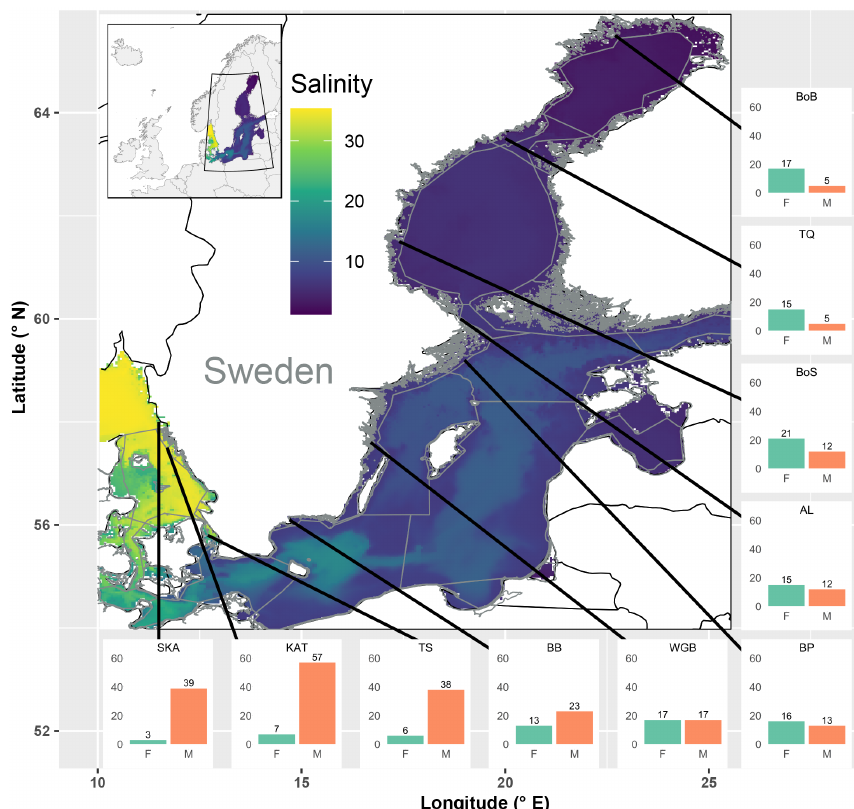
Figure 3. Map of the study area covering the Baltic Sea and the Skagerrak, colour-coded by mean salinity. Grey lines delineate sub-basins and shallow coastal areas. Bar plots show standardized fish species richness for shallow coastal areas in each of the 10 assessed sub-basins, separately for species of freshwater (F) and marine (M) origin. SR was standardized across sub-basins to similar sample coverage (Table S5). Black lines indicate the positions of the sub-basins, but the exact sampling sites were spread across the shallow areas of each of the